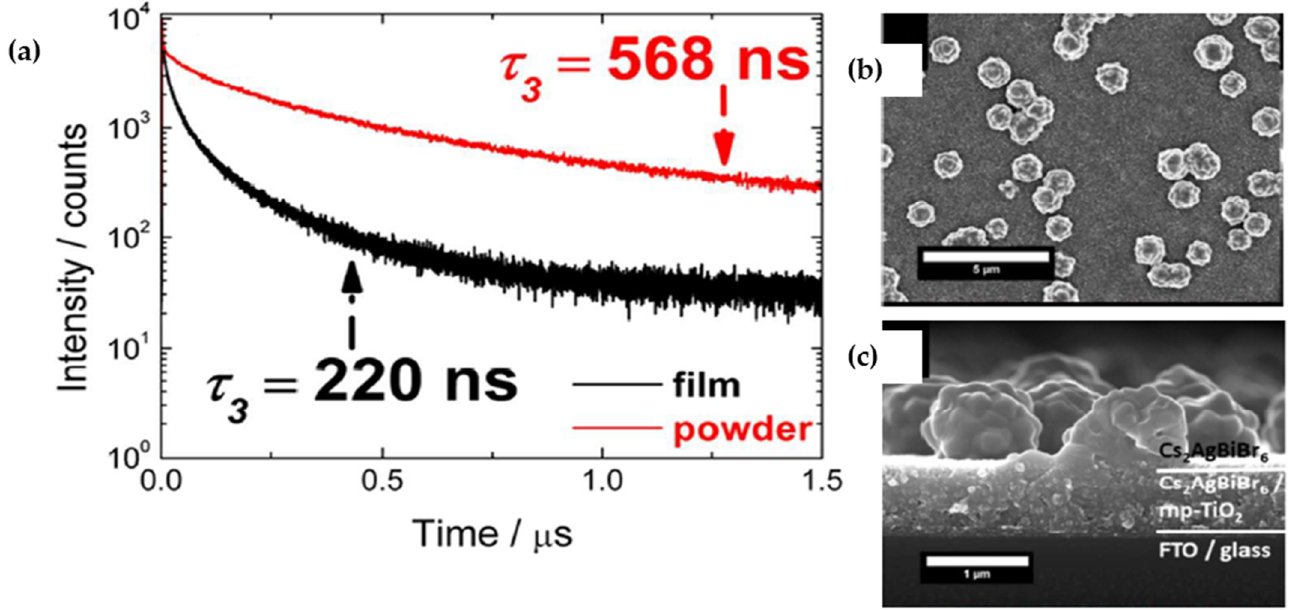
Figure 9. ( a ) TCSPC decays of a Cs 2 AgBiBr 6 film on glass and polycrystalline powder; ( b ) SEM top-view and; ( c ) SEM cross-section images of the Cs 2 AgBiBr 6 film prepared with a 75 °C preheating step on mp-TiO 2 . Reproduced with permission from [77] . Copyright 2017, Royal Society of Chemistry.